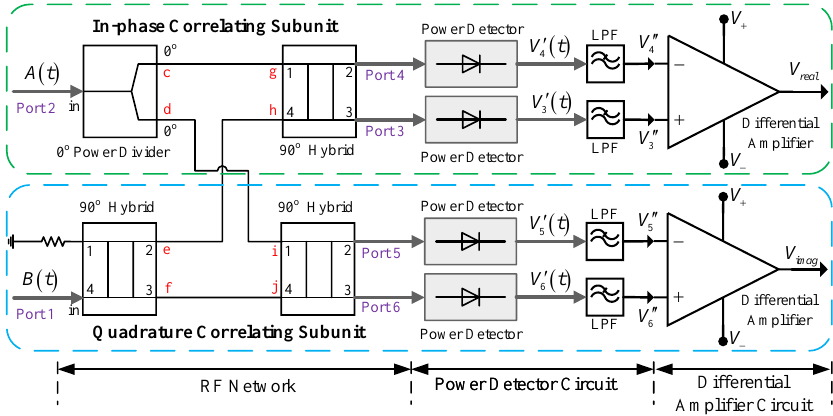
Figure 1. A block diagram of the diode-based analog complex cross-correlator.